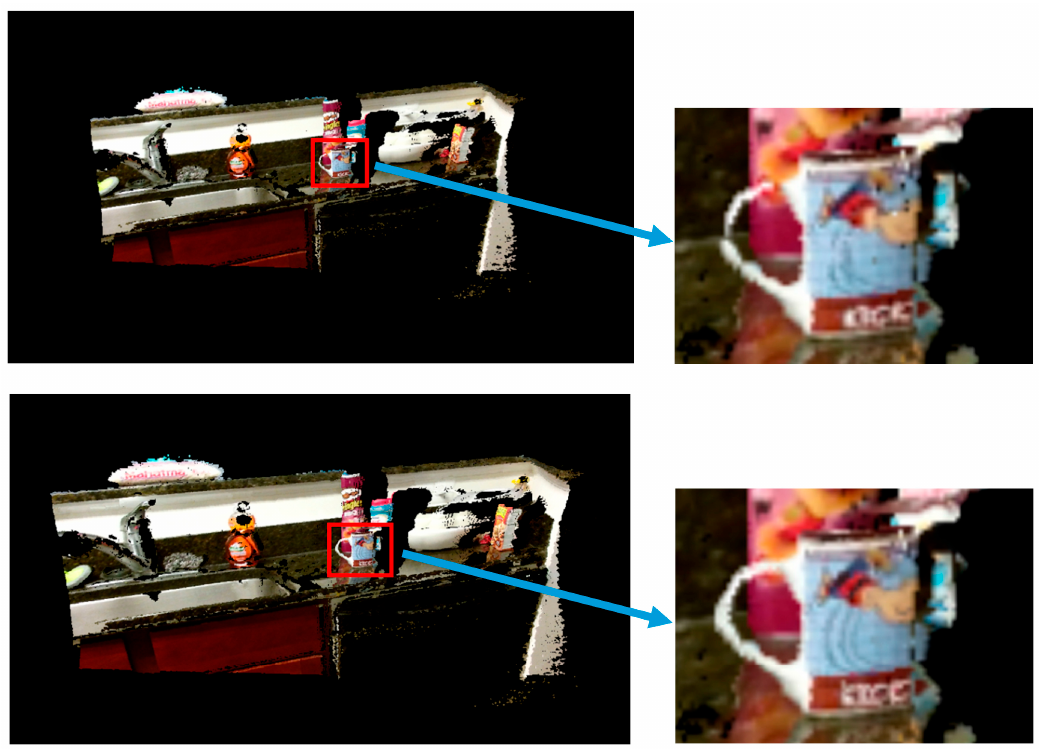
Figure 11. A point cloud of the GMU Kitchen Dataset before ( top ) and after ( bottom ) correction using the post-rectification approach.